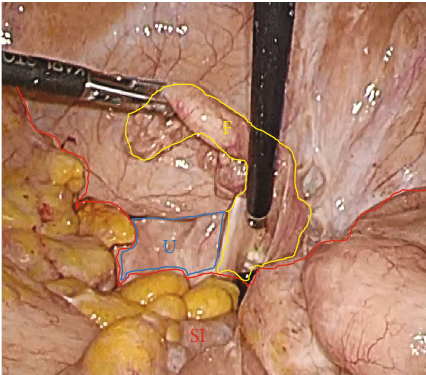
Figure 3: Laparoscopic fi ndings. The uterus (U) was atrophied by radiation therapy and strongly adhered to the small intestine (SI); mobility was very poor. The fallopian tube (F) could be detected.